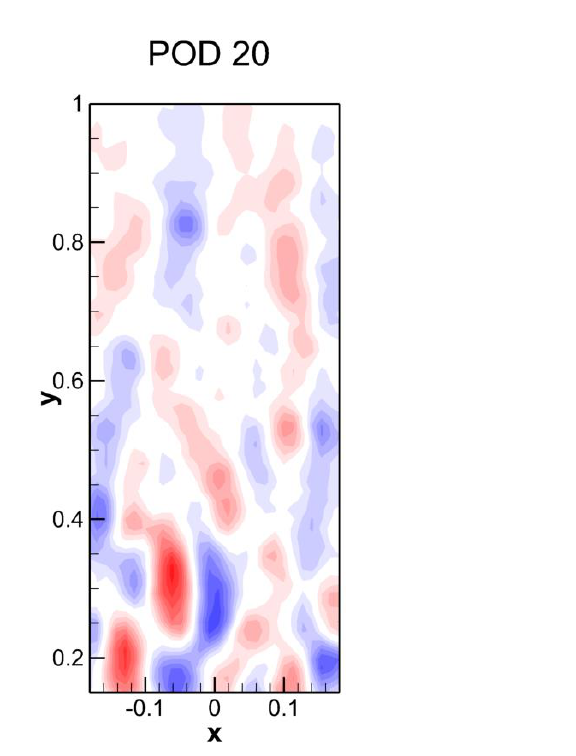
Fig. 19. Vorticity POD mode No. 20, 0.71% TE.